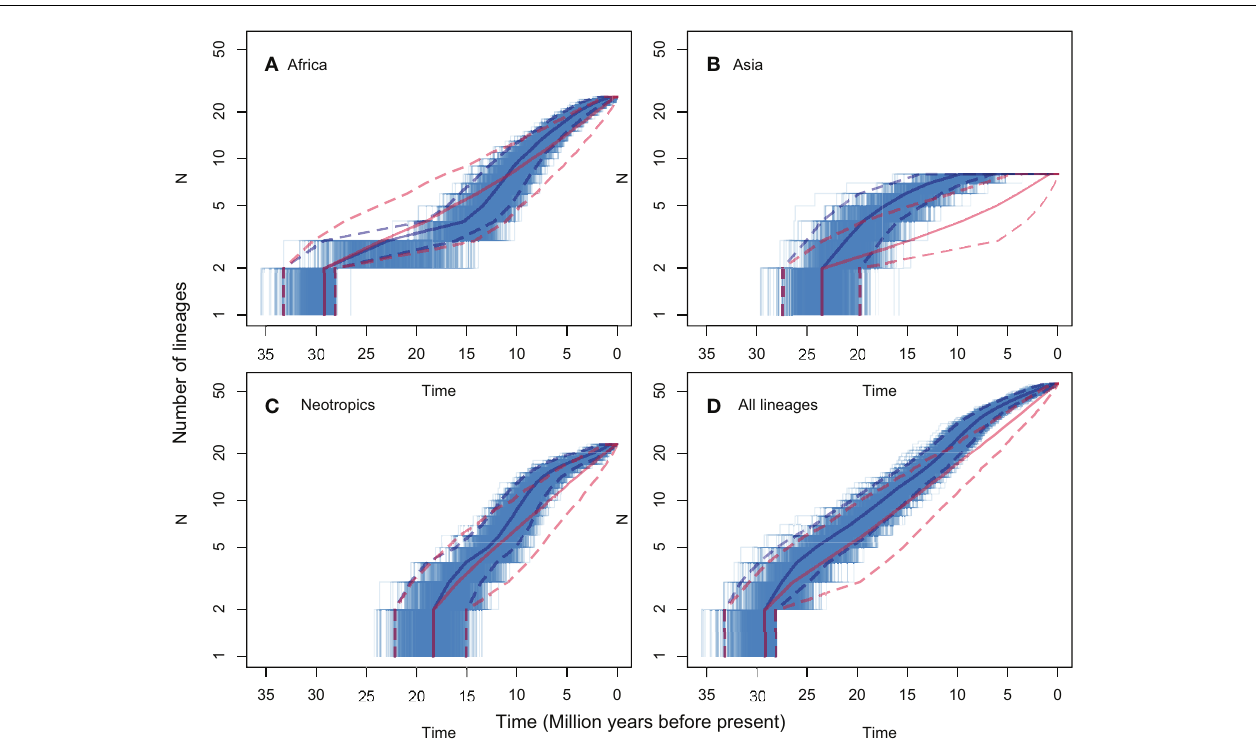
FIGURE 3 | LTT plots for lineages that included only those species from each of Africa (A), Asia (B), the Neotropics (C), and all species of Manilkara s.s. (D). Each plot shows the median and 95% HPD of the ages for each number of lineages in solid and dashed lines, respectively. The lines for observed trees are shown in blue and for the trees